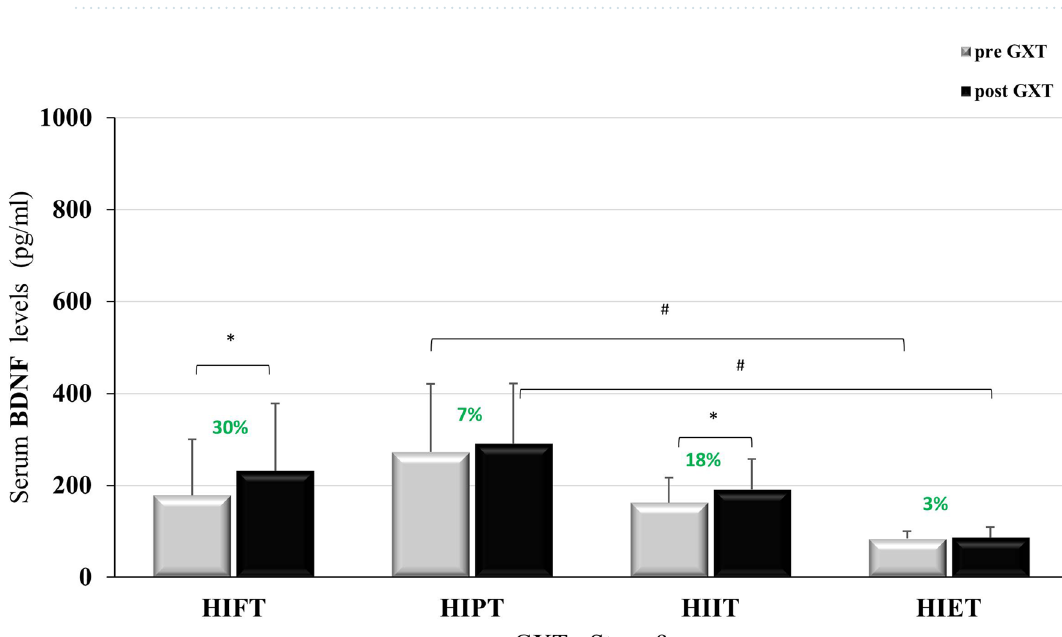
Figure 1. BDNF level at baseline, pre- and post GXT; *p < 0.05.